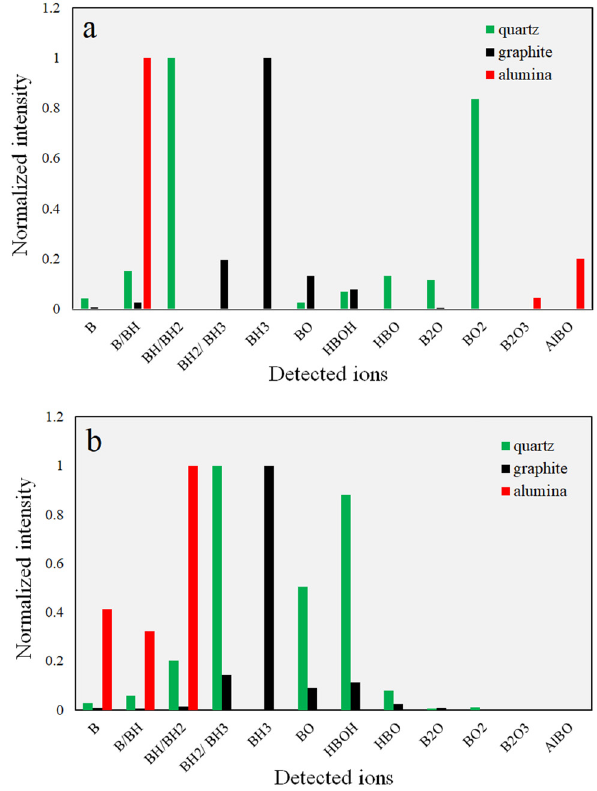
Figure 5: The measured species in MBMS results: ( a ) He – 5% H 2 , ( b ) He – 5% H fi ed with 3 – 5% H ( Detected oxide com - 2 humidi 2 O. pounds in ( a ) is due to partial pressures of oxygen remaining in the chamber )